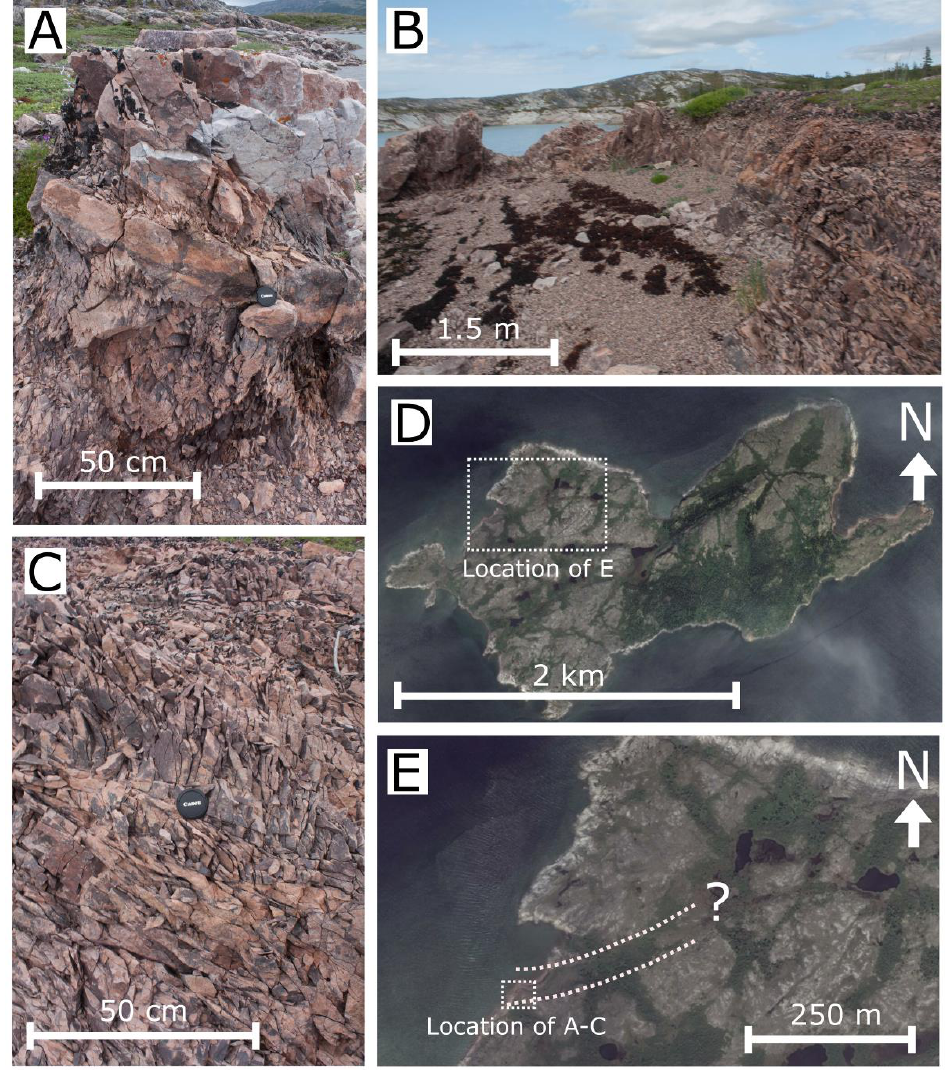
Figure 6. Field ( A – C ) and Google Earth images ( D , E ) of a zone of extensive intense brittle deformation on Big Island north of Makkovik. Subfigure ( E ) shows the possible continuation of this zone inland. ( A , C ) are looking southwest whereas ( B ) is looking northeast.